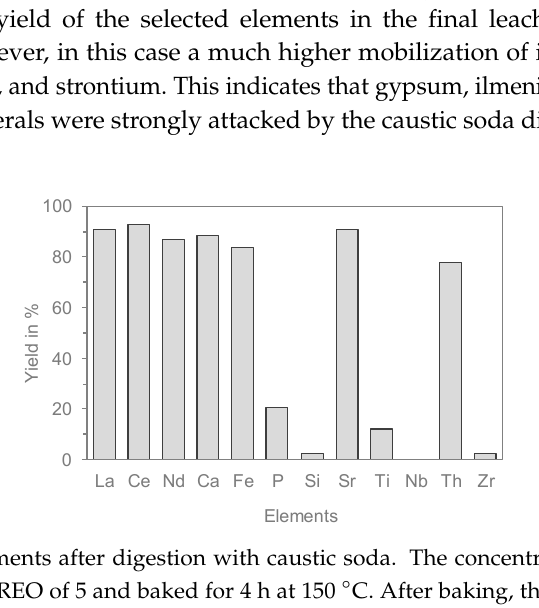
Figure 6. Yields of elements after digestion with concentrated sulfuric acid at different temperatures and times. In all experiments, the ratio of concentrated sulfuric acid to rare earth oxide (REO) was 5. After digestion, the cake was leached with water at a solid:liquid (S:L) ratio of 10 for 1 h at room temperature.